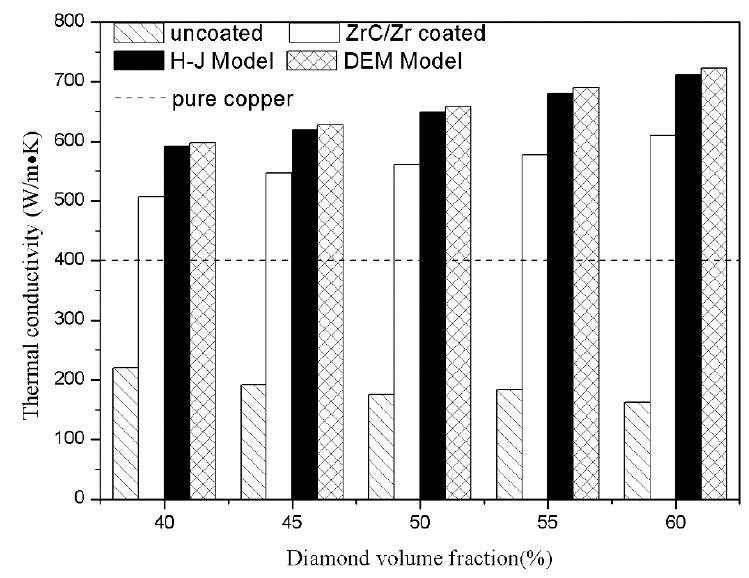
Figure 6. TCs of uncoated and ZrC/Zr-coated diamond-copper composites in comparison with theoretical values.